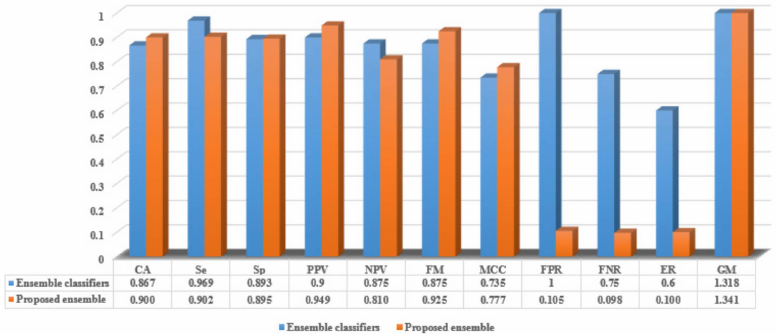
Figure 9. A comparison between the proposed ensemble and maximum results of other